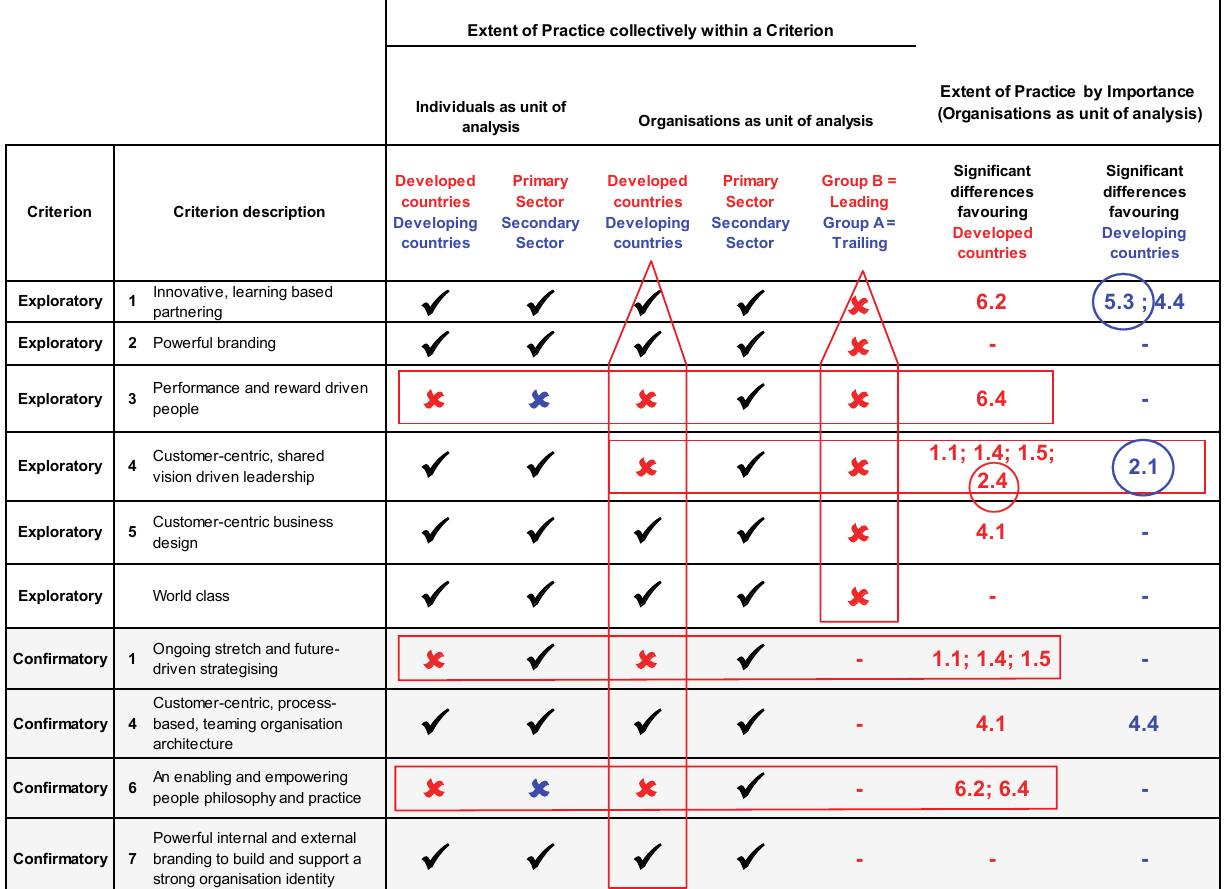
TABLE 7 Summary of